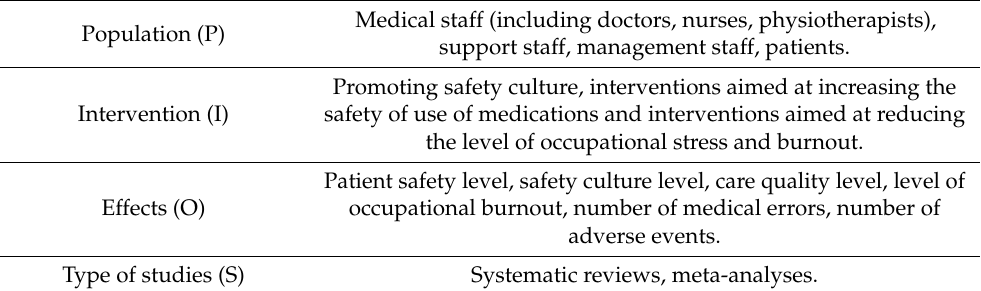
Table 1. Inclusion criteria for a systematic review. Medical staff (including doctors, nurses, physiotherapists), Population (P) support staff, management staff,